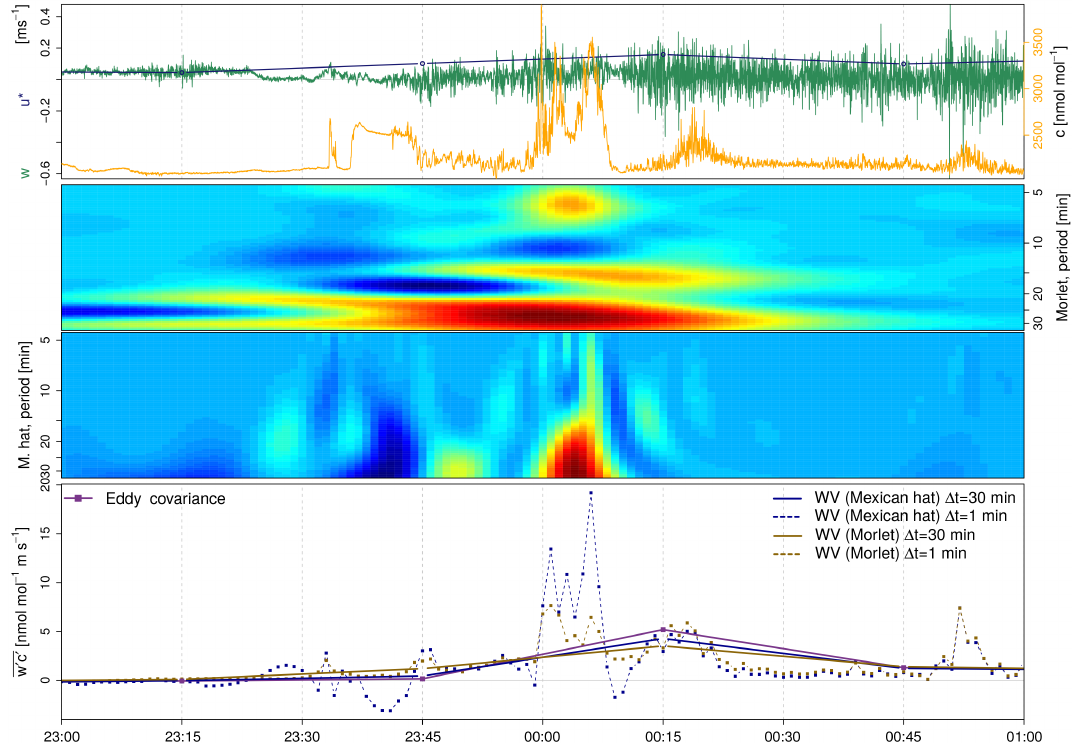
Figure 5. Case study of 2/3 August 2014. The colours in the wavelet cross-scalograms between w and c denote the flux intensity: blue refers to the smallest, green to medium and red to highest methane flux contributions. The cone of influence is outside of the scalogram, i.e. it was not affected by border effects. The third panel shows in solid lines the 30min fluxes determined using the classical eddy covariance method as well as the 1min fluxes of the wavelet method averaged on the same 30min interval. Dashed lines represent wavelet fluxes with an averaging period of